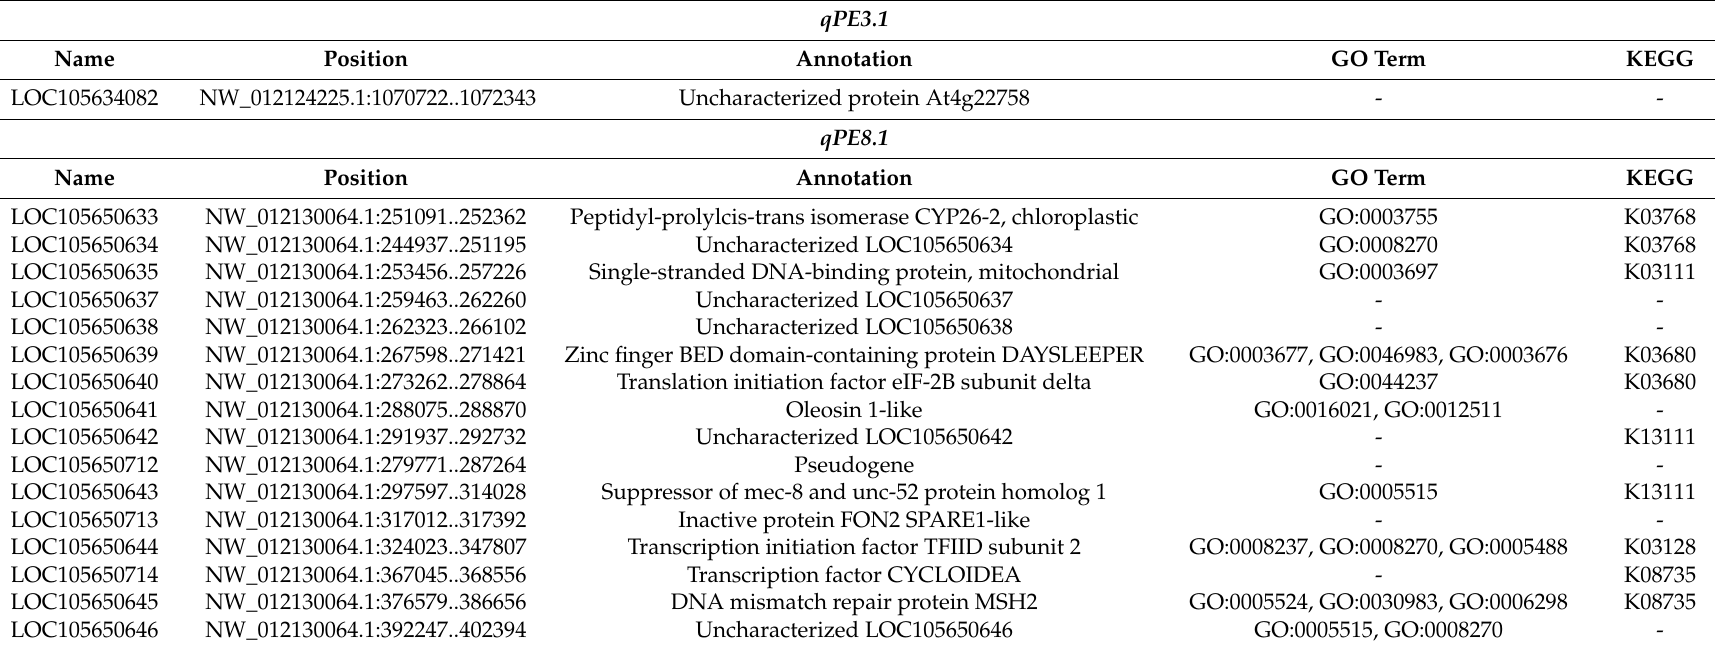
Table 3. Annotated genes located between markers CN_SSR325 and CN_SSR326 flanking qPE3.1 and between markers NG288C and NG286A flanking QTL qPE8.1 that controls seed phorphol esters content detected in the Jatropha F 2 population of Chai Nat × M10 by inclusive composite interval mapping. The data are from Jatropha curcas Database